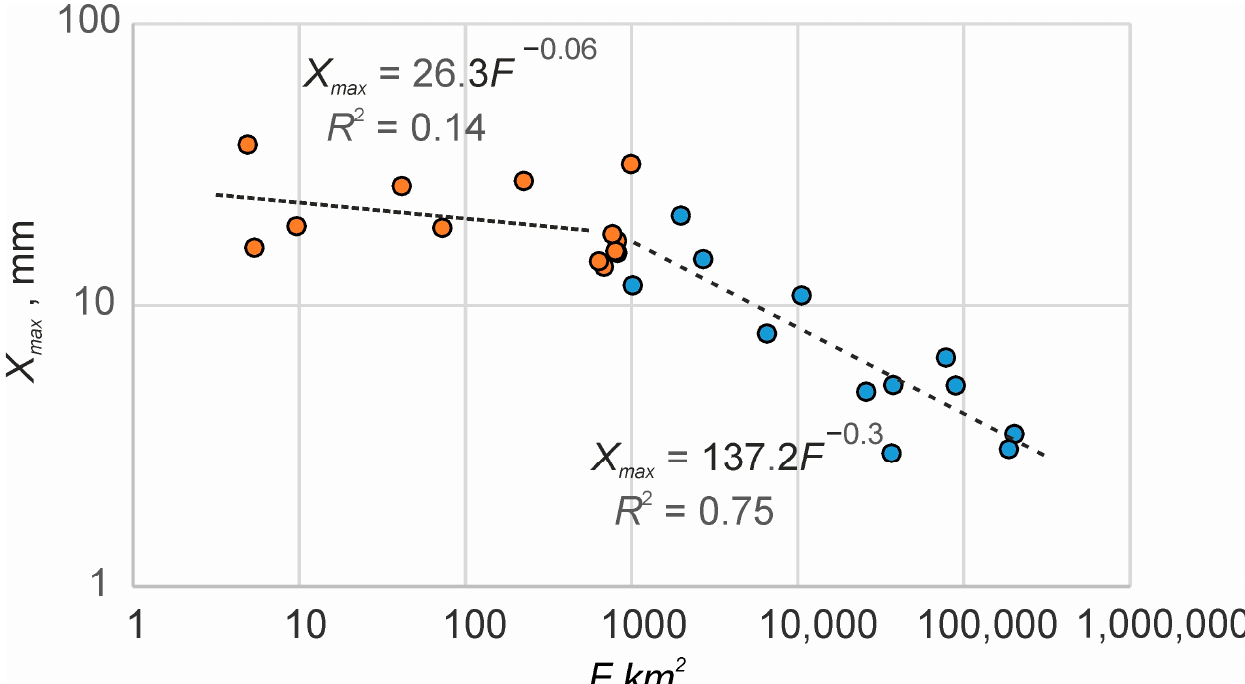
Figure 5. The relationship between effective maximum daily surface runoff depth and the contributing basin area for the Vilyui River basin (East Siberia), with taiga landscapes and deep permafrost. Red circles—basins with areas ≤ 1000 km 2 , blue circles—>1000 km 2 .